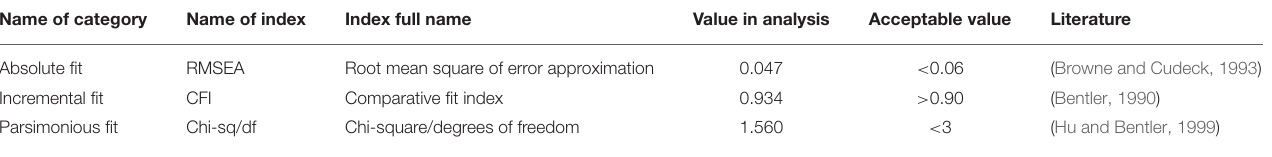
TABLE 2 | Pooled CFA model fitness